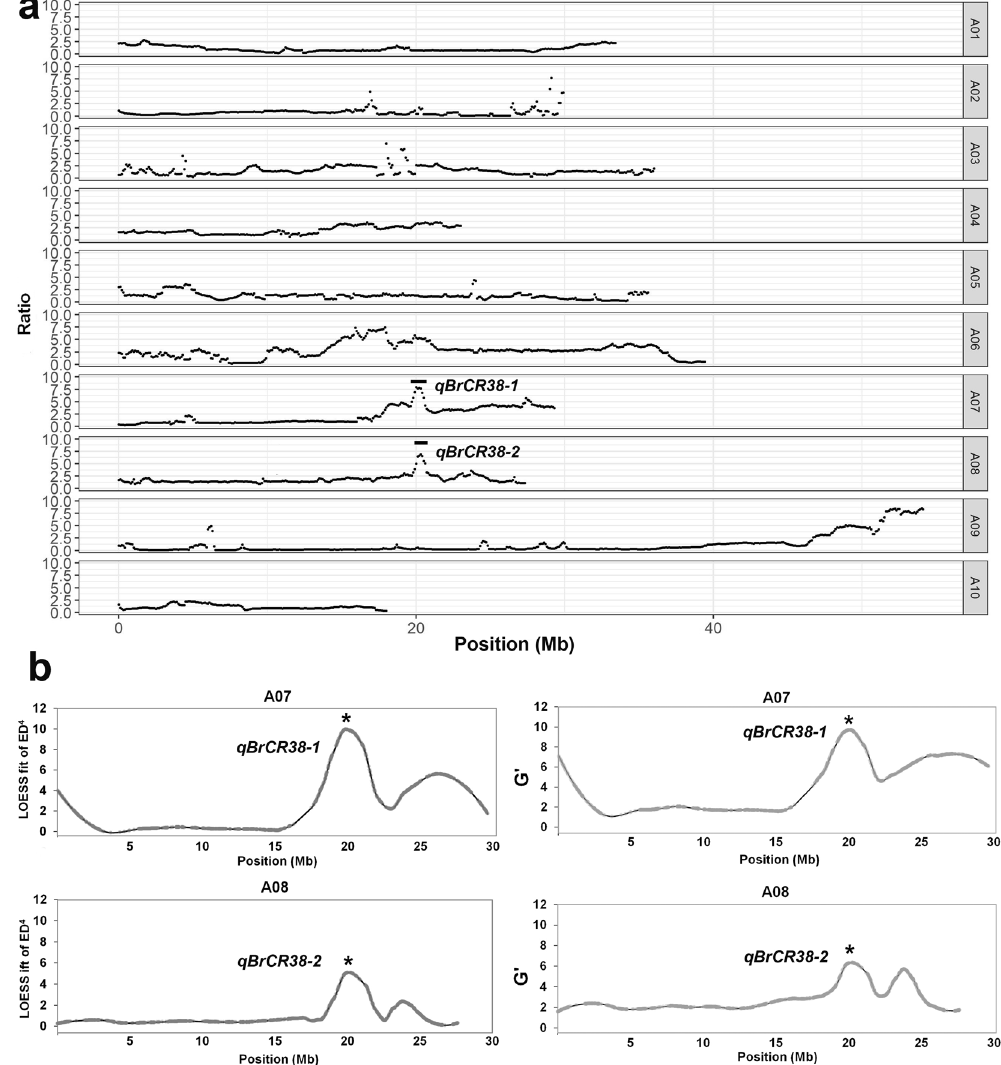
Figure 2. Genome-wide scan for clubroot resistance QTLs using BSA-seq. Two significant QTL of qBrCR38-1 and qBrCR38-2 detected in chromosomes A07 and A08 using three statistical approach. ( a ) Ratio (CR-pool/CS- pool) of the SNP-ratios (Resistant alleles/sensitive alleles) is presented. The significance peak is indicated by the horizontal dotted line. ( b ) Distribution of G’value and Loess fit curve calculated using ED 4 data on